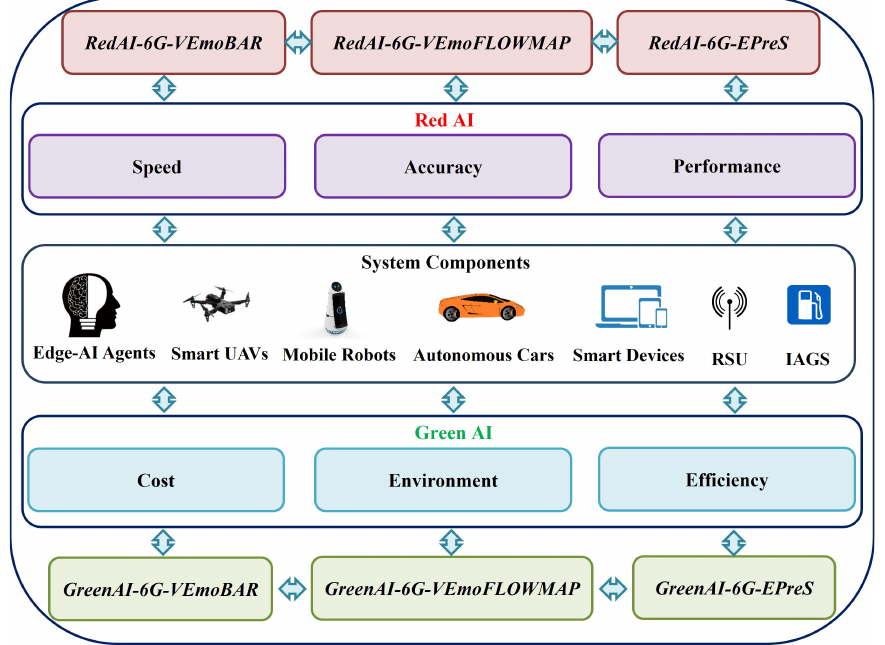
Figure 3. A brief overview of the proposed 6G convergent infrastructure with two differential perspectives: Red AI and Green AI